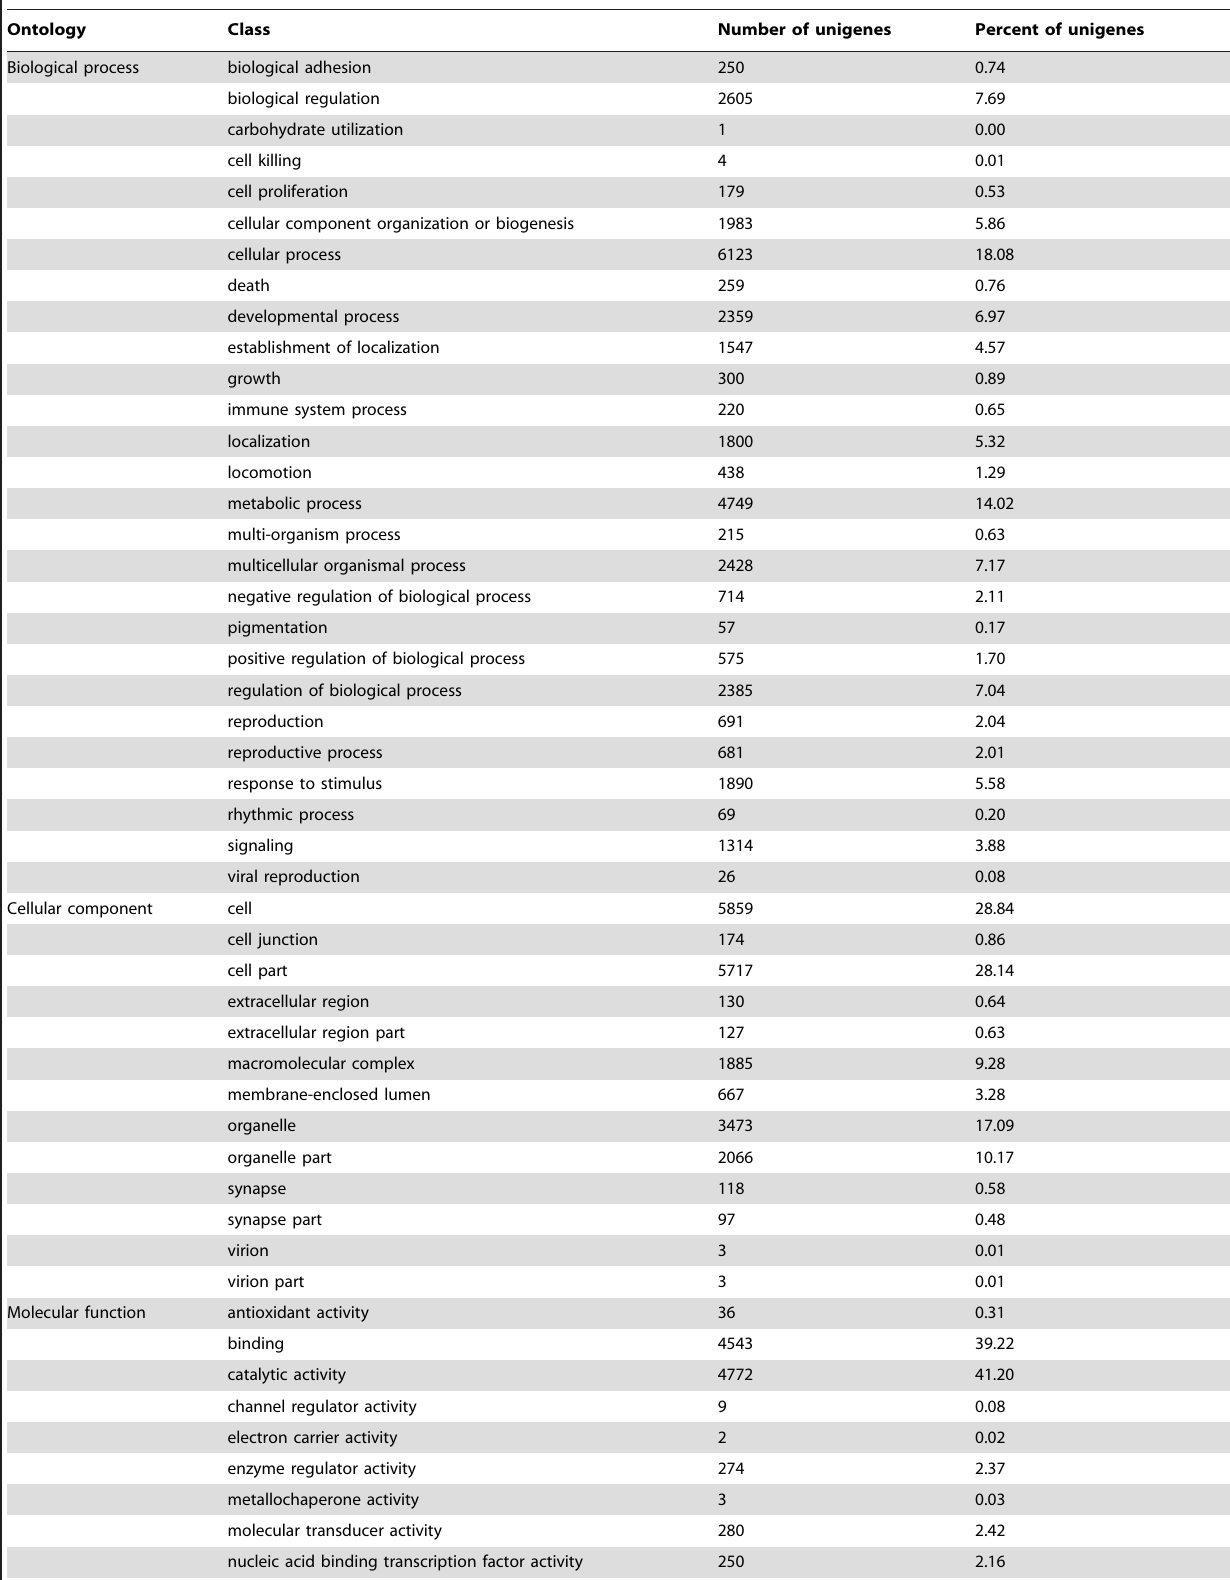
Table 2. GO classifications of assembled unigenes.